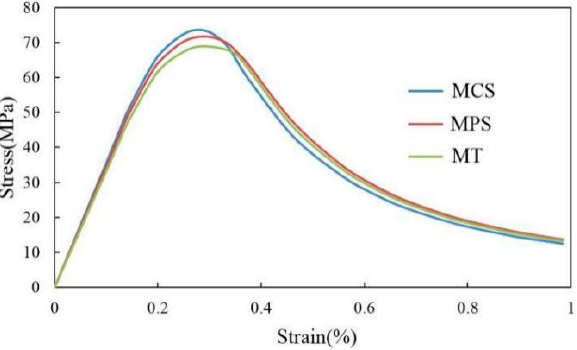
Figure 18. Uniaxial compression stress–strain curve of mortar (M2).